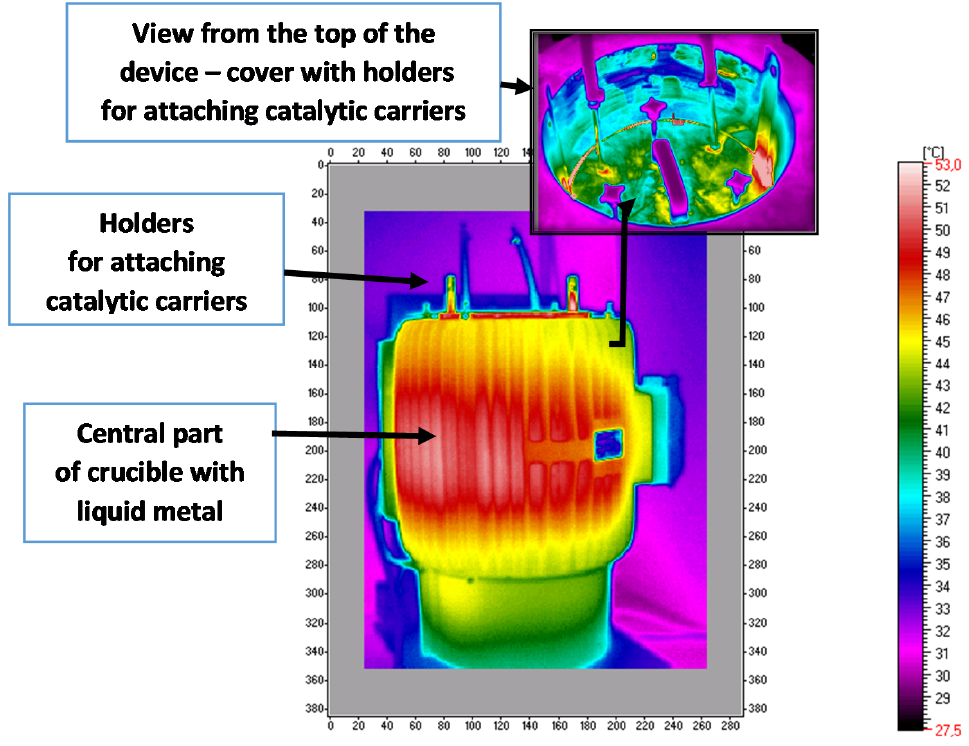
Figure 9. Temperature distribution on the lateral surface of the device with an mhd pump .